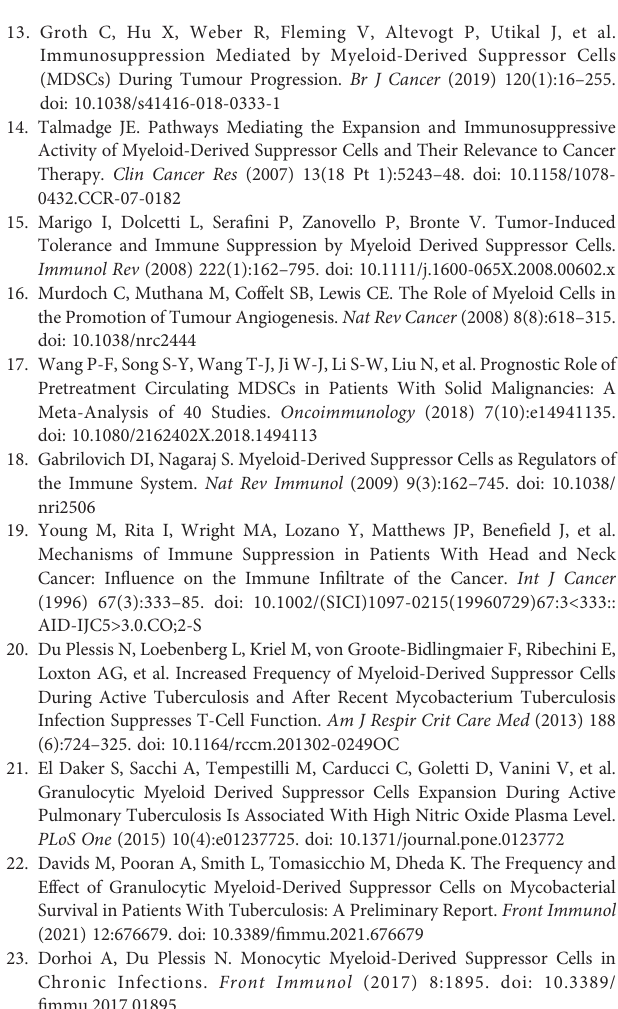
Supplementary Figure 1 | D Ct-values for all 43-genes assessed for differential expression between MDSC and monocytes in the PB of active TB patients. Results are given for the 16X (pink) and 20X (blue) pre-ampli fi cation cycles. Supplementary Figure 2 | D Ct-values for all 43-genes assessed for differential expression between MDSC and AM in the BALF of active TB patients. Results are given for the 16X (pink) and 20X (blue) pre-ampli fi cation cycles. Supplementary Figure 3 | D Ct-values for all 43-genes assessed for differential expression between MDSC in the PB and BALF of active TB patients. Results are given for the 16X (pink) and 20X (blue) pre-ampli fi cation